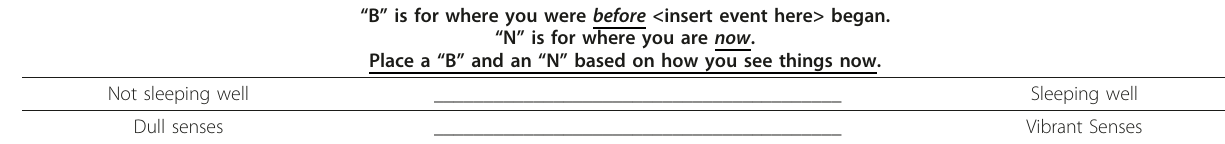
Table 7 Sample Items Showing Pair Layout “ B ” is for where you were before <insert event here> began. “ N ” is for where you are now . Place a “ B ” and an “ N ” based on how you see things